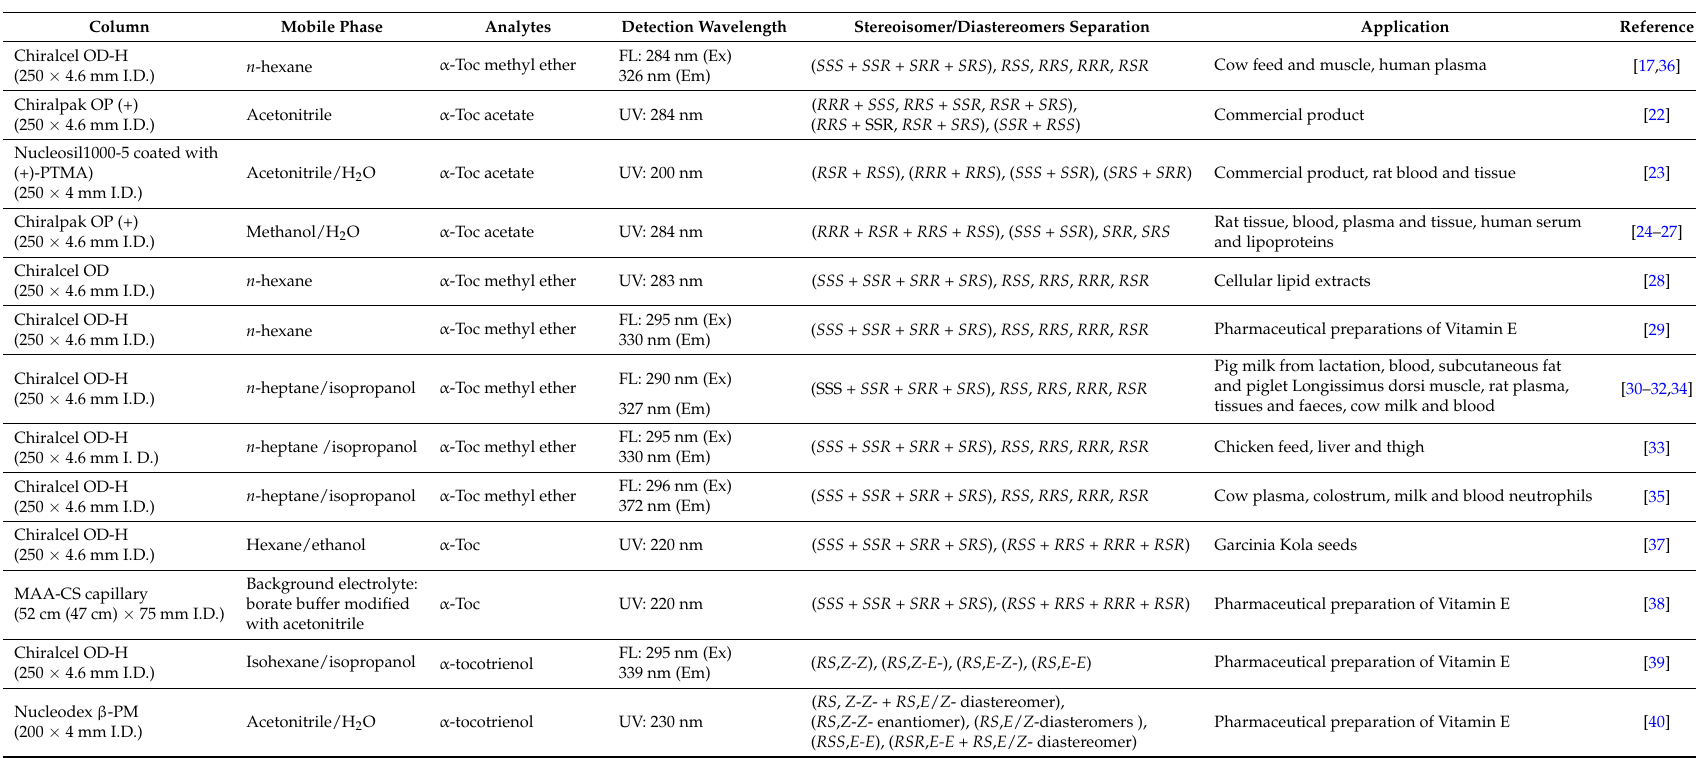
Table 1. HPLC methods for α -Toc and α -, β -, γ -, and δ -tocotrienol